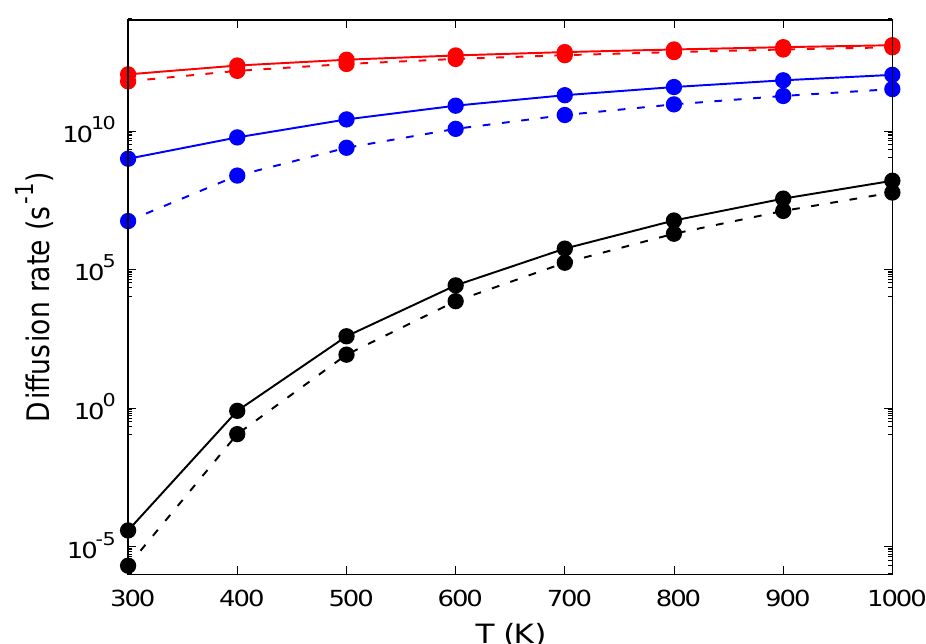
Figure 4. Hydrogen diffusion rates for the three pathways investigated in this study. Results for int-int are in black, int-int2 in red, and oct-int in blue. Solid lines denote the quantum result and dashed lines the classical